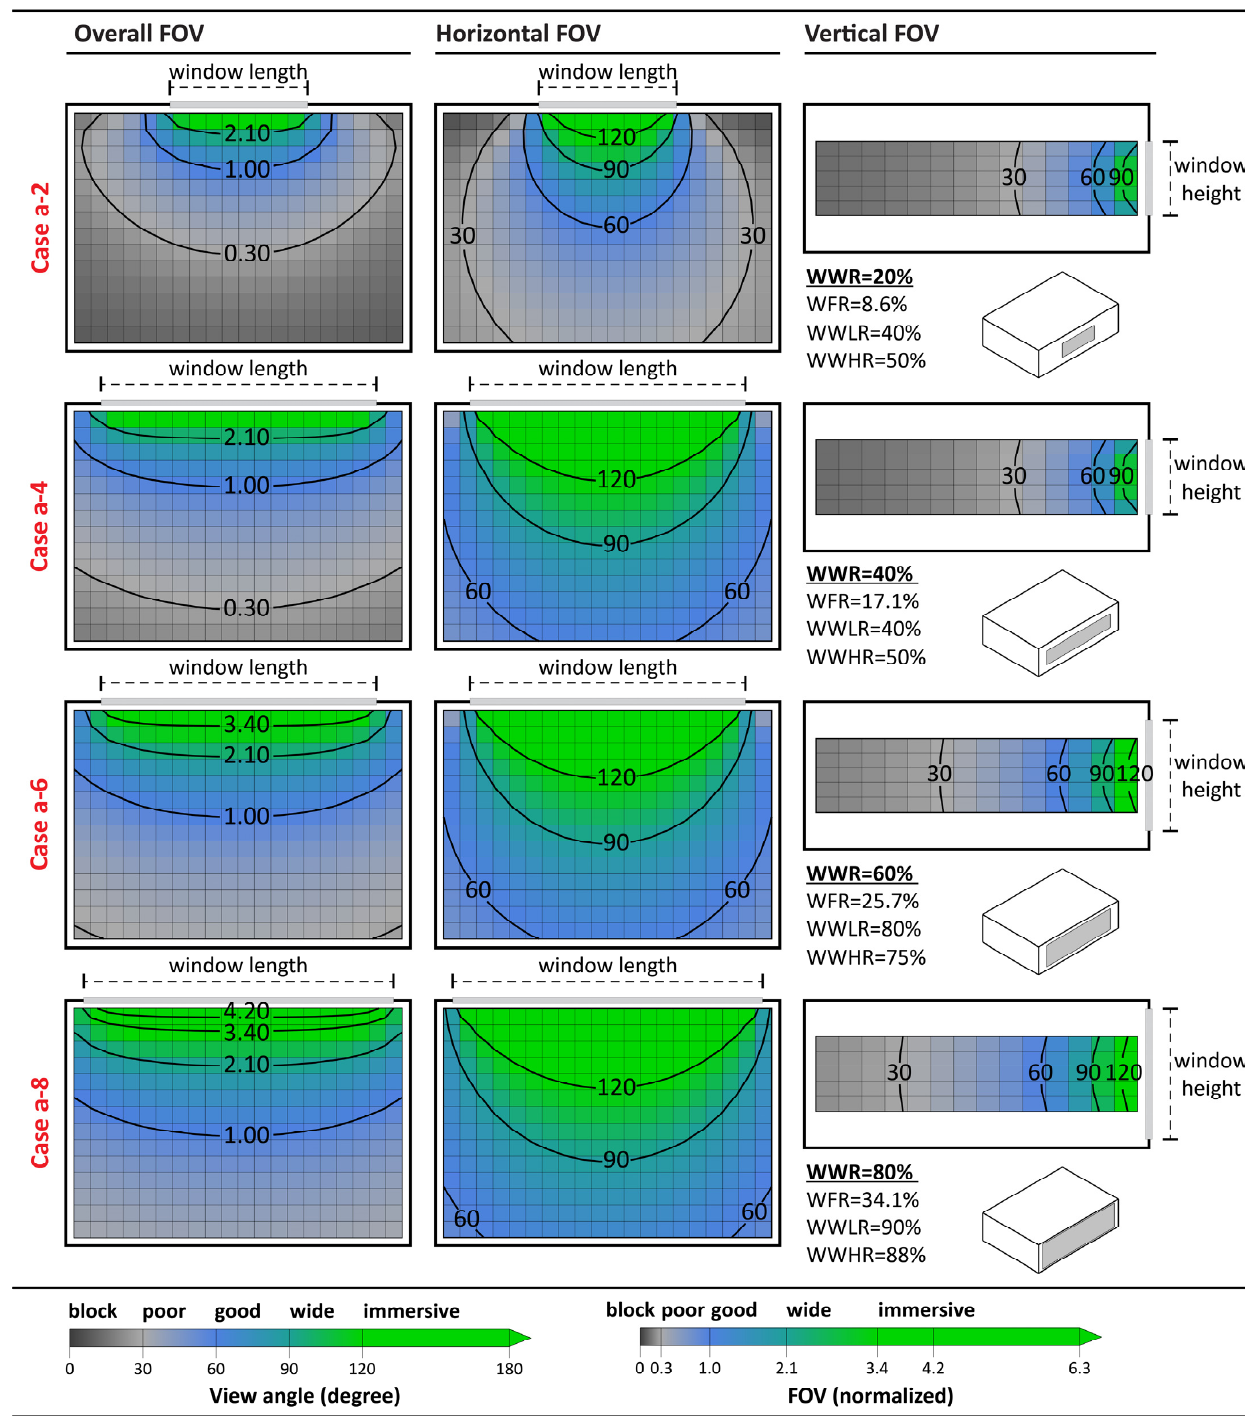
Figure 7. Examples of view access in false color maps in terms of computed overall, horizontal, and vertical FOVs in scenario-a, including case studies with different window